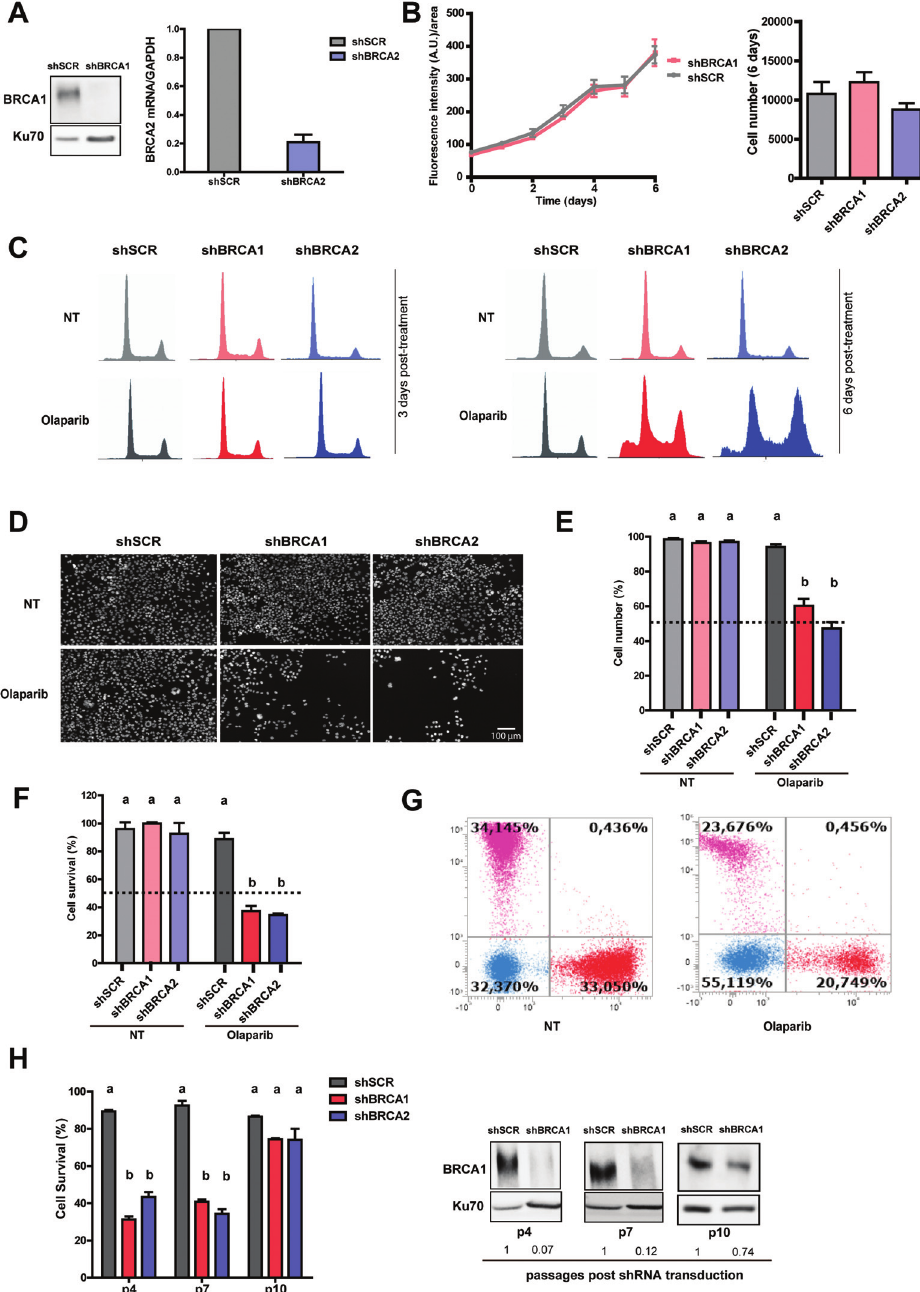
Figure 1 - BRCA1 and BRCA2 downregulation sensitize colorectal cancer HCT116 p21-/- cells to Olaparib treatment. A) HCT116 p21-/- were transduced with control (shSCR_scramble) and shRNA vectors specific for BRCA1 and BRCA2 (shBRCA1 and shBRCA2). Western blot and RT-qPCR showing the levels of BRCA1 and BRCA2 protein and mRNA, respectively, at passage 4 after transduction. B) Growth curves of untreated samples. Data are shown as mean (cid:6) SD from 5 independent experiments. C) Flow cytometry of propidium iodide-stained samples. D) Representative panels depicting the SL induced in the HCT116 p21-/- cells after BRCA downregulation. Samples were stained with DAPI and photographs were obtained after automatic cap- ture. E-F) HCT116 p21-/- cells transduced with shSCR and shRNA vectors specific for BRCA1 and BRCA2 (shBRCA1 and shBRCA2) were plated at a density of 1500 cells/well in 96 well plates. Six days later, samples were counted with direct (automatized cell counter-E) and indirect (F-cell titer Glo) methods. The plot shows the quantification (mean (cid:6) SD) of the surviving fraction of 3 independent experiments. G) HCT116 p21-/- cells were transduced withfluorescentproteinstogeneratecoloredpoolsasdescribedinthematerialandmethodssection.AftershRNAtransduction,sampleswereco-cultured andtreatedwithOlaparibwhenindicated.Theplotshowsthequantificationofthesurvivingfractionof3independentexperiments.H)Syntheticlethality (SL) is lost with increasing cell passages (mean (cid:6) SD, n= 2). Western blot showing BRCA1 levels at different times post shRNA transduction. Numbers below each lane are the quantification of normalized BRCA1 levels. Cell number was determined at the indicated passages and the SL was